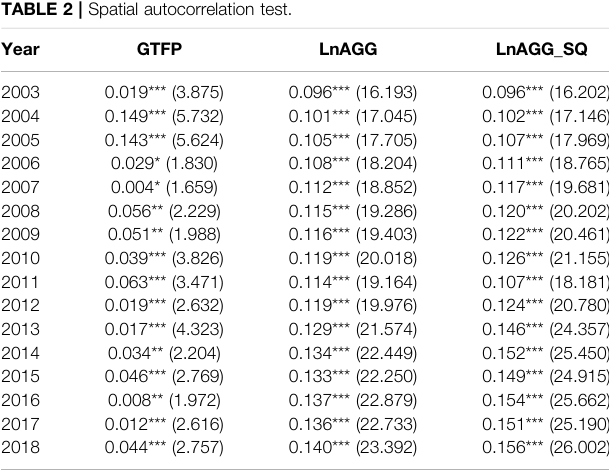
TABLE 2 | Spatial autocorrelation